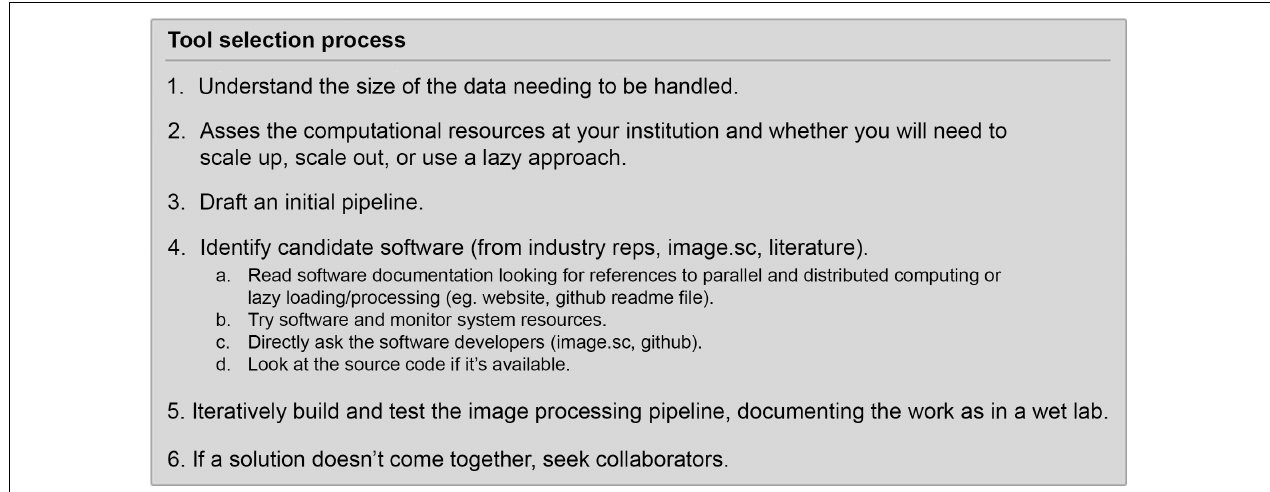
FIGURE 6 | Outline of software tool selection process.